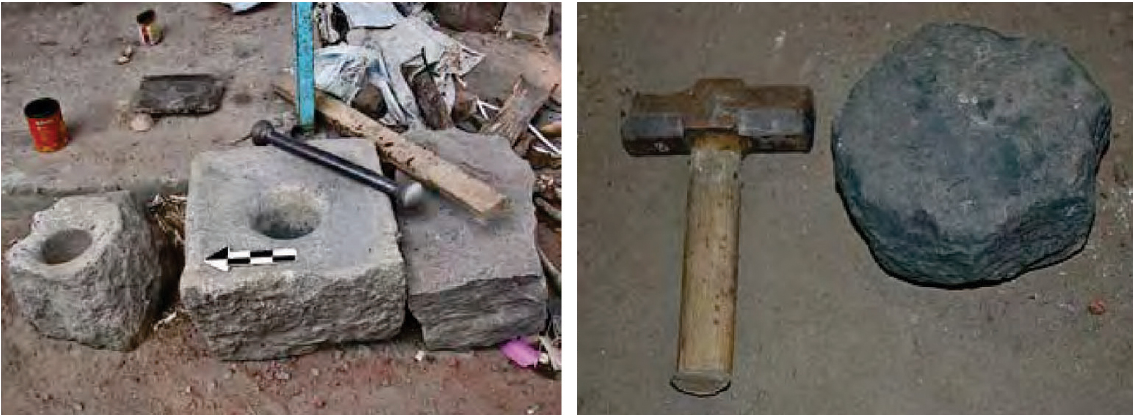
Figure 17. Swamimalai ground stone tools used to process slag recovered from crucibles and workshop floor: mortars and large anvil (left); dimpled hammerstone used as both a hammer and a small anvil (right; Source: Levy et al.